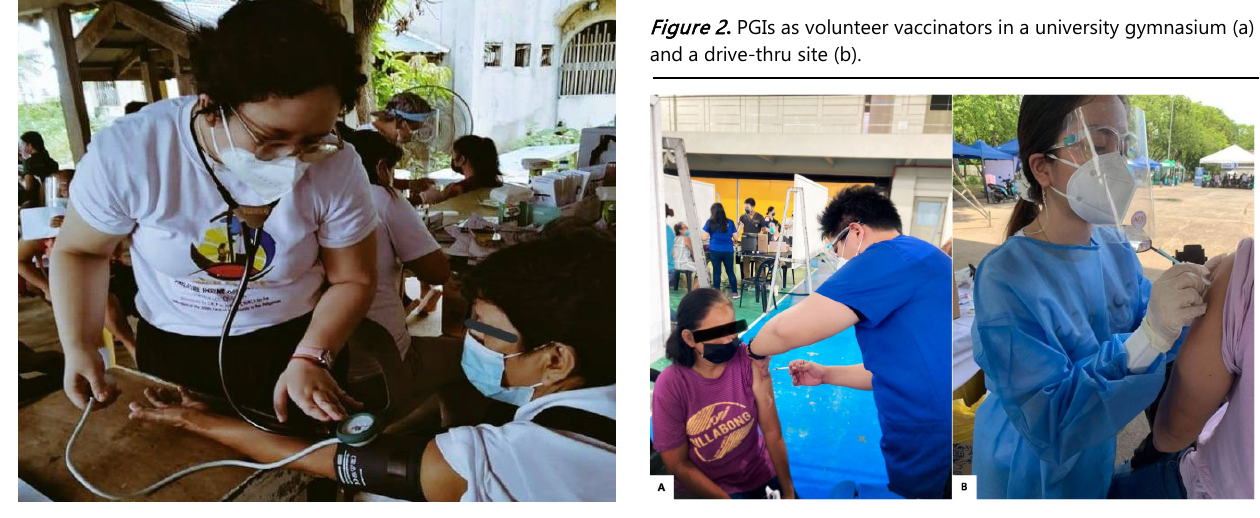
Figure 1 . Postgraduate intern (PGI) as a volunteer screener in a vaccination drive in a rural community.